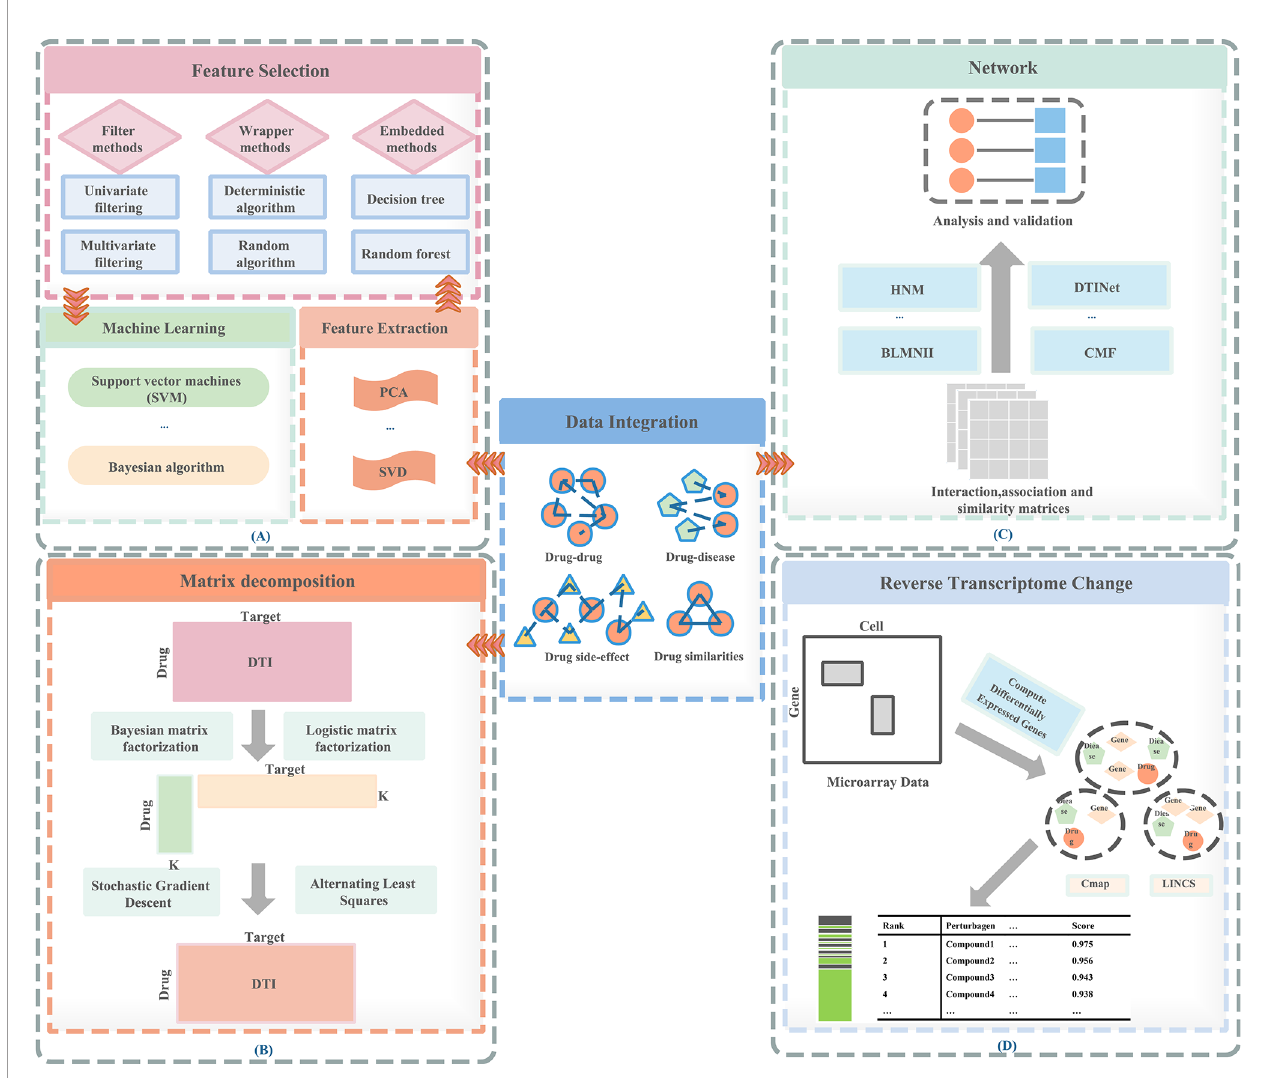
FIGURE 1 | Methods of drug repositioning. (A) Feature-based methods, (B) matrix decomposition – based methods, (C) network-based methods, (D) reverse transcriptome change – based